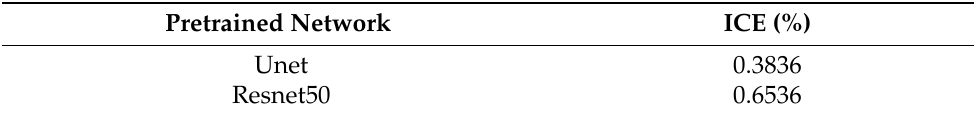
Table 1. The individual counting error results are